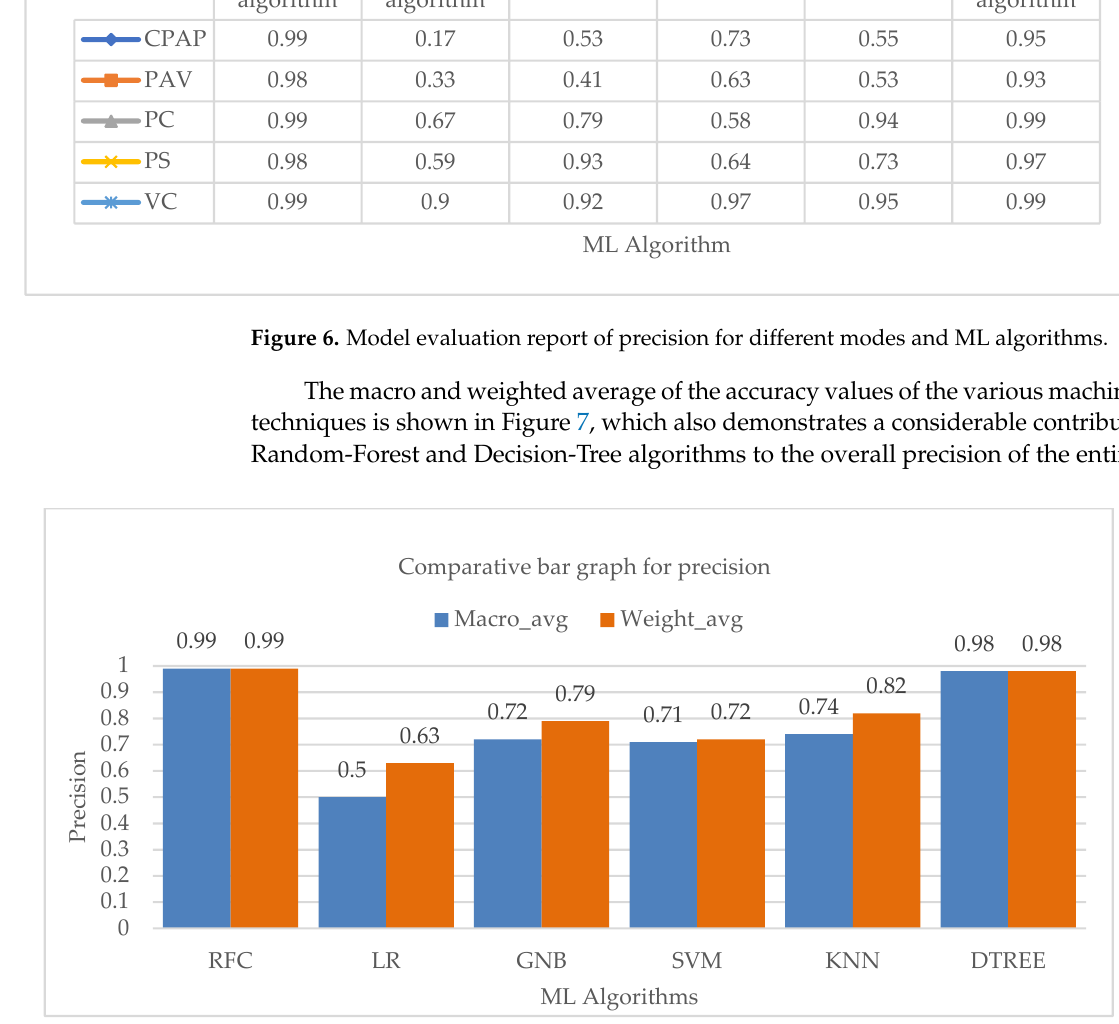
Figure 7. Bar chart visualization of precision comparison among different ML algorithms.